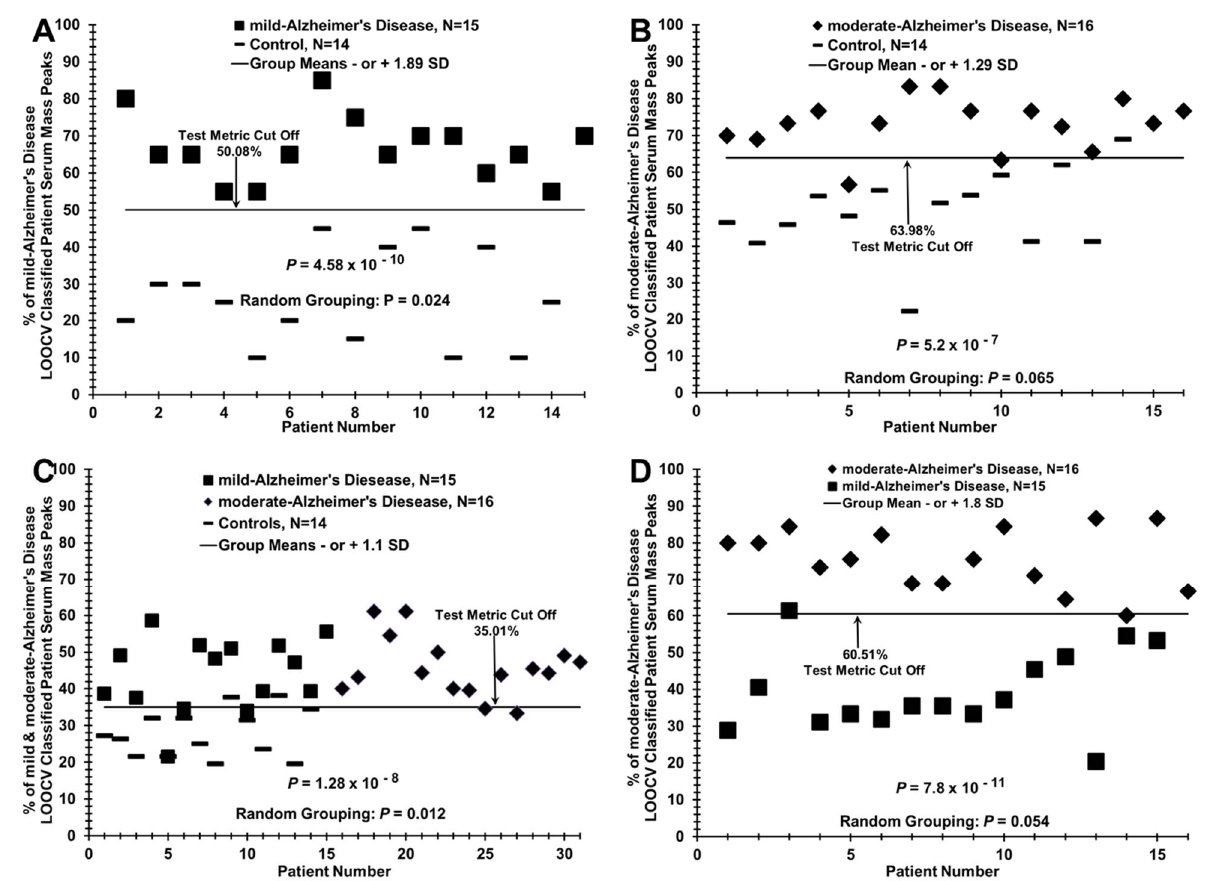
Figure 5. LOOCV/PCV discrimination of sera from AD patients versus control individuals, and mild AD patient sera versus moderate AD patient sera using a lower cost, desktop mass spectrometer. ( A ) Distinguishing mild AD patient sera (dark squares) from controls (dashes). ( B ) Discriminating moderate AD patient sera (dark triangles) from controls (dashes). ( C ) Distinguishing AD patient sera as a group ( N = 31, mild [dark squares] and moderate [dark diamonds]) from controls (dashes). ( D ) Distinguishing mild AD patient sera (dark diamonds) versus moderate AD patient sera (dark squares).